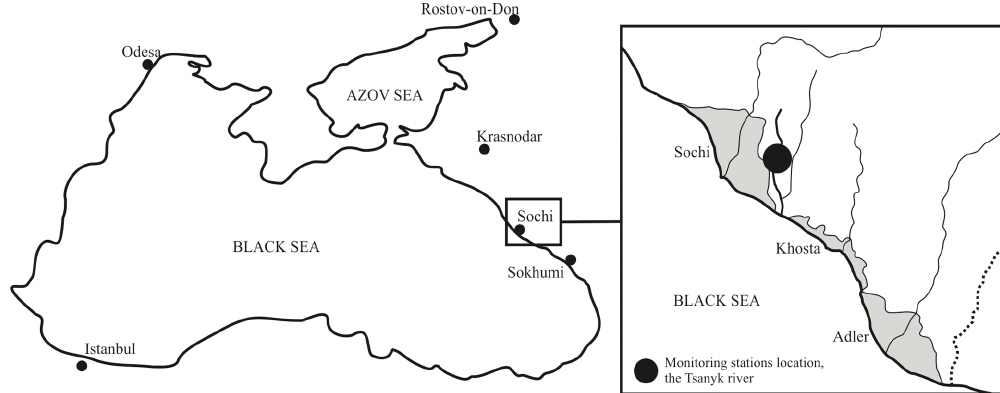
Figure 1. The study site